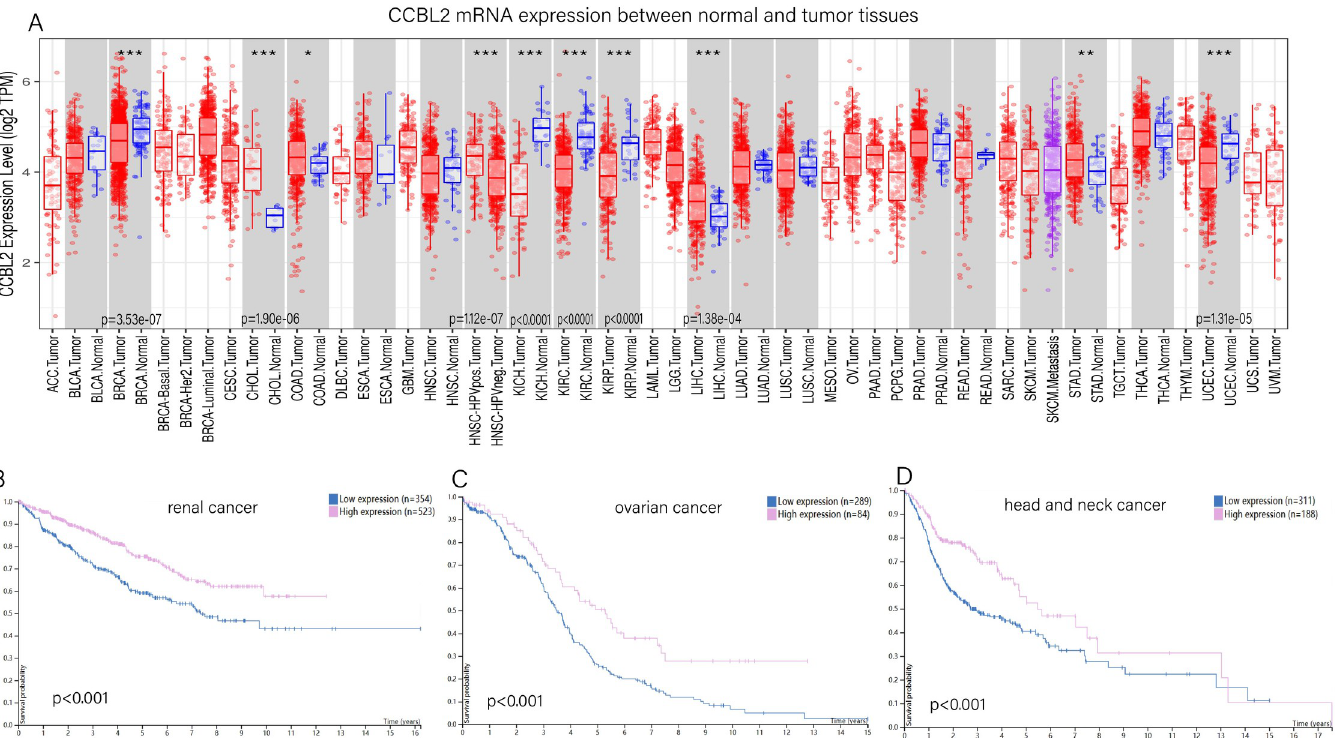
Fig 11. Pan-cancer analysis of CCBL2 . Differential expression of CCBL2 between normal and tumor tissues(A). Low CCBL2 expression had relations with the low survival probability of renal cancer (B) and ovarian cancer (C) and head and neck cancer (D) (p < 0.0010). Data were obtained from Human Protein Atlas Dataset available from proteinatlas.org and TIMER